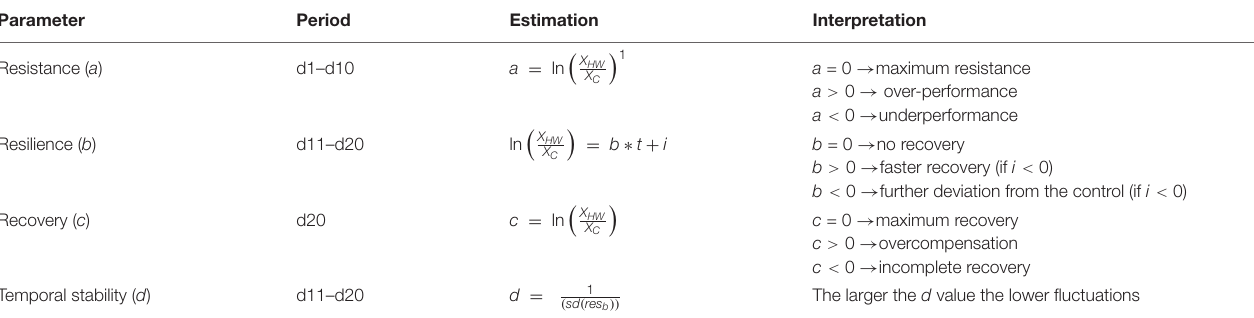
TABLE 2 | Stability parameters estimated in the present study and the experimental period that they are calculated for, as well as their mathematical definition and